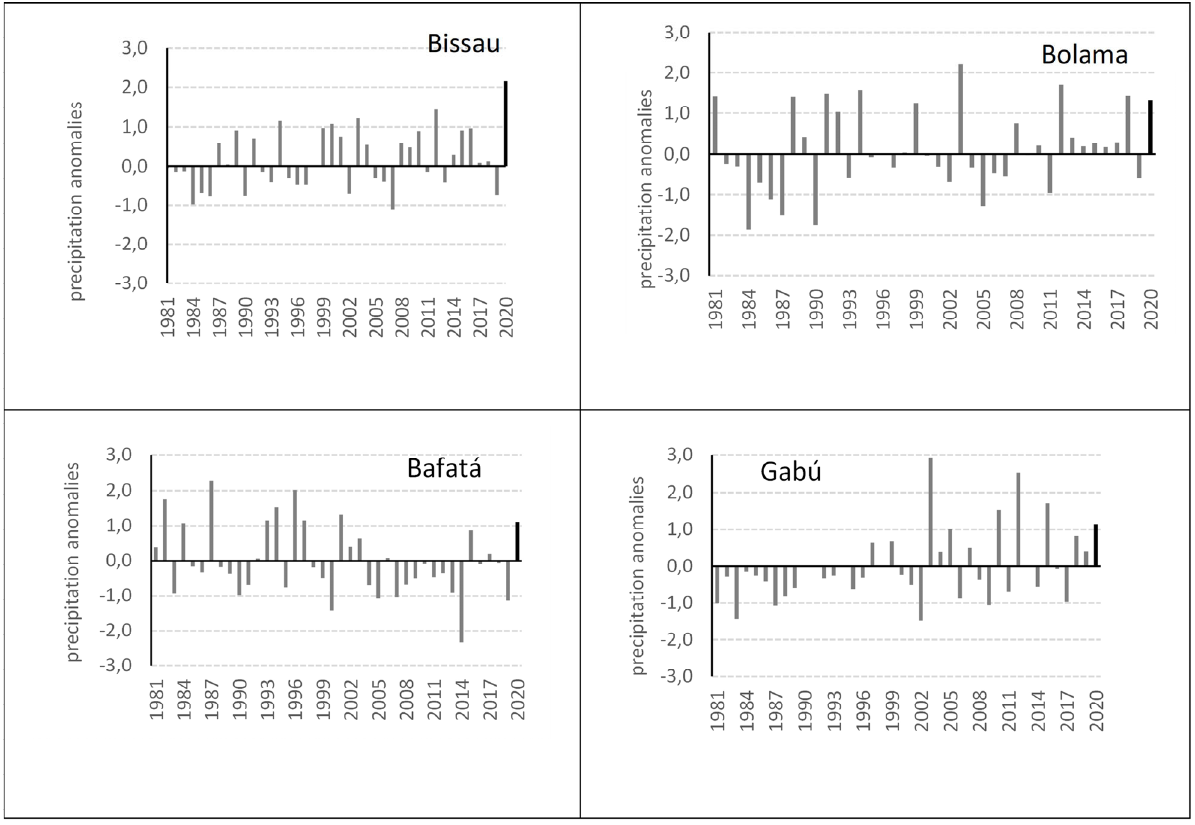
Figure 4. Annual rainfall anomalies in four stations of Guinea-Bissau over 1981–2020. The 2020 anomalies are represented by dark columns. Data source: National Institute of Meteorology of Guinea ‐ Bissau.